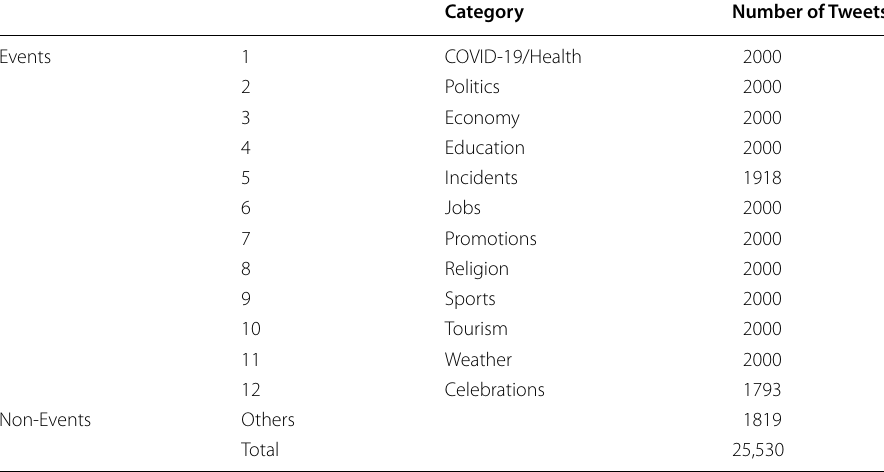
Table 1 Number of Tweets for events and non-events